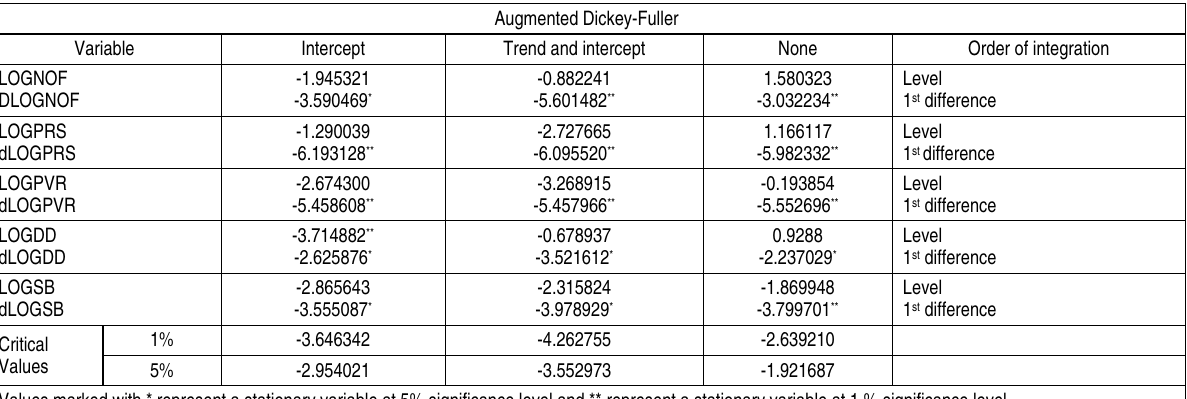
Table 3. Results of ADF